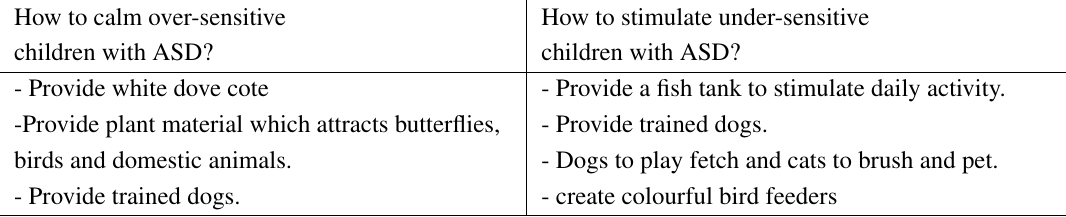
Table 17. How to use therapeutic animals in creating specific influences (Wilson, 2006)